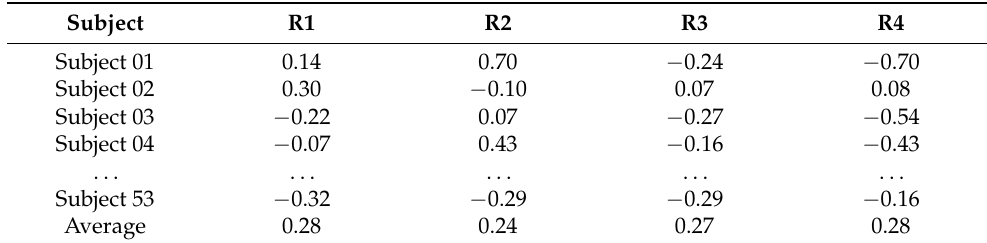
Table 5. Pearson correlation coefficient (PCC) between signal quality indices and error rate of respiration rate estimated based on the EEMD-PCA method for different